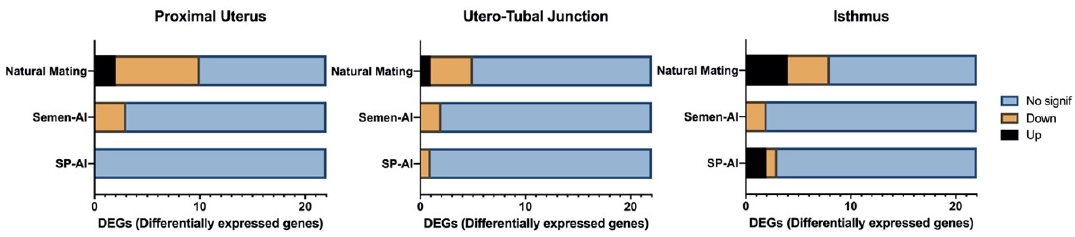
Figure 3. Number of differentially-expressed genes (DEGs) present in proximal uterus, utero-tubal junction, and isthmus tissues. Upregulated genes ( p < 0.05) are represented in black and downregulated genes ( p < 0.05) in orange color. Non-significant genes are represented in blue. Thus, in ProxUt tissue (Figure 2), natural mating upregulated FKBP5 and PTGS1 but downregulated FKBP4, PTGS2, HSD11B1 ( q < 0.05), STAT1, STAT2, STAT3, STAT5A ( q < 0.05), and STAT5B ( p < 0.05). Semen-AI downregulated HSD11B2, FKBP4, and STAT5B ( p < 0.05) while SP-AI